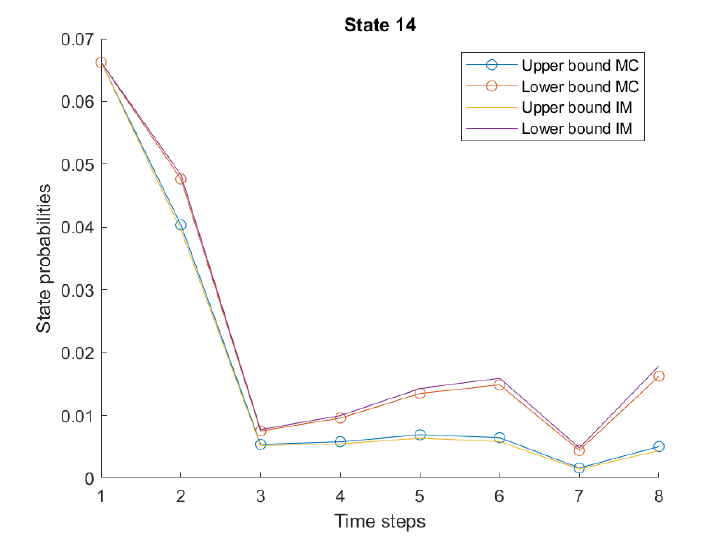
Figure 7. Monte Carlo (MC) and Interval Mathematics (IM) bounds for the probability of state 14, in case of dependent uncertainty sources.